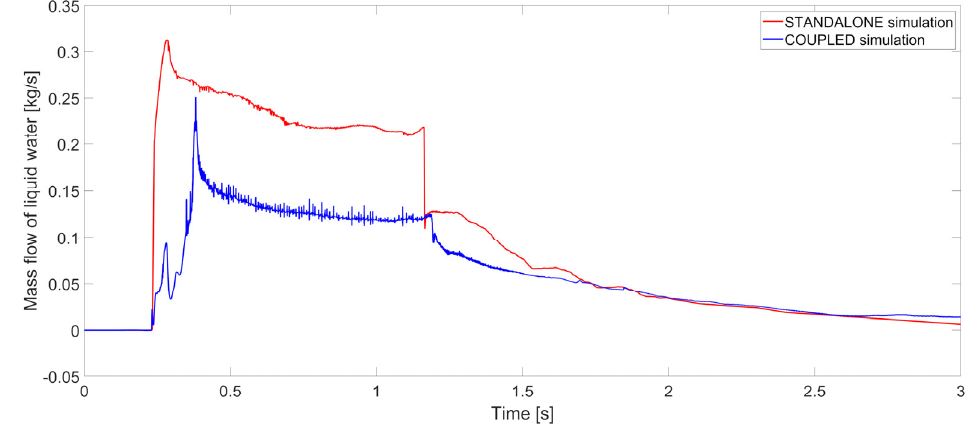
Figure 18. Temperature evolution in S1B for coupled simulations at different radial and axial positions (refer to Table 5).